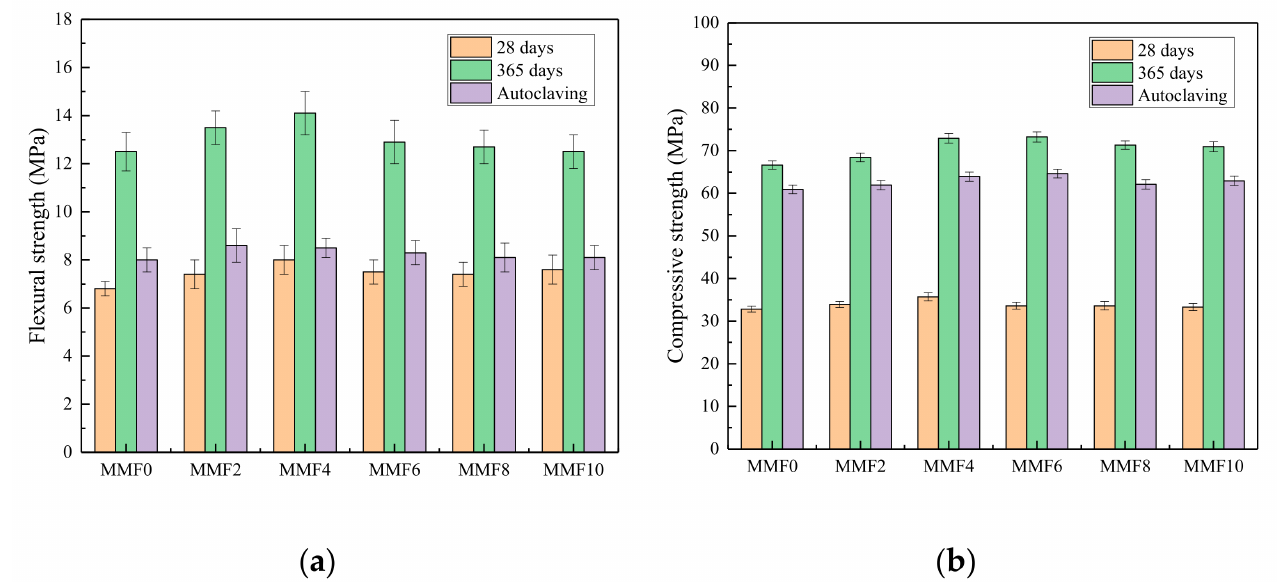
Figure 7. Effect of nano-MgO content on mortar strength. ( a ) flexural strength and ( b ) compressive